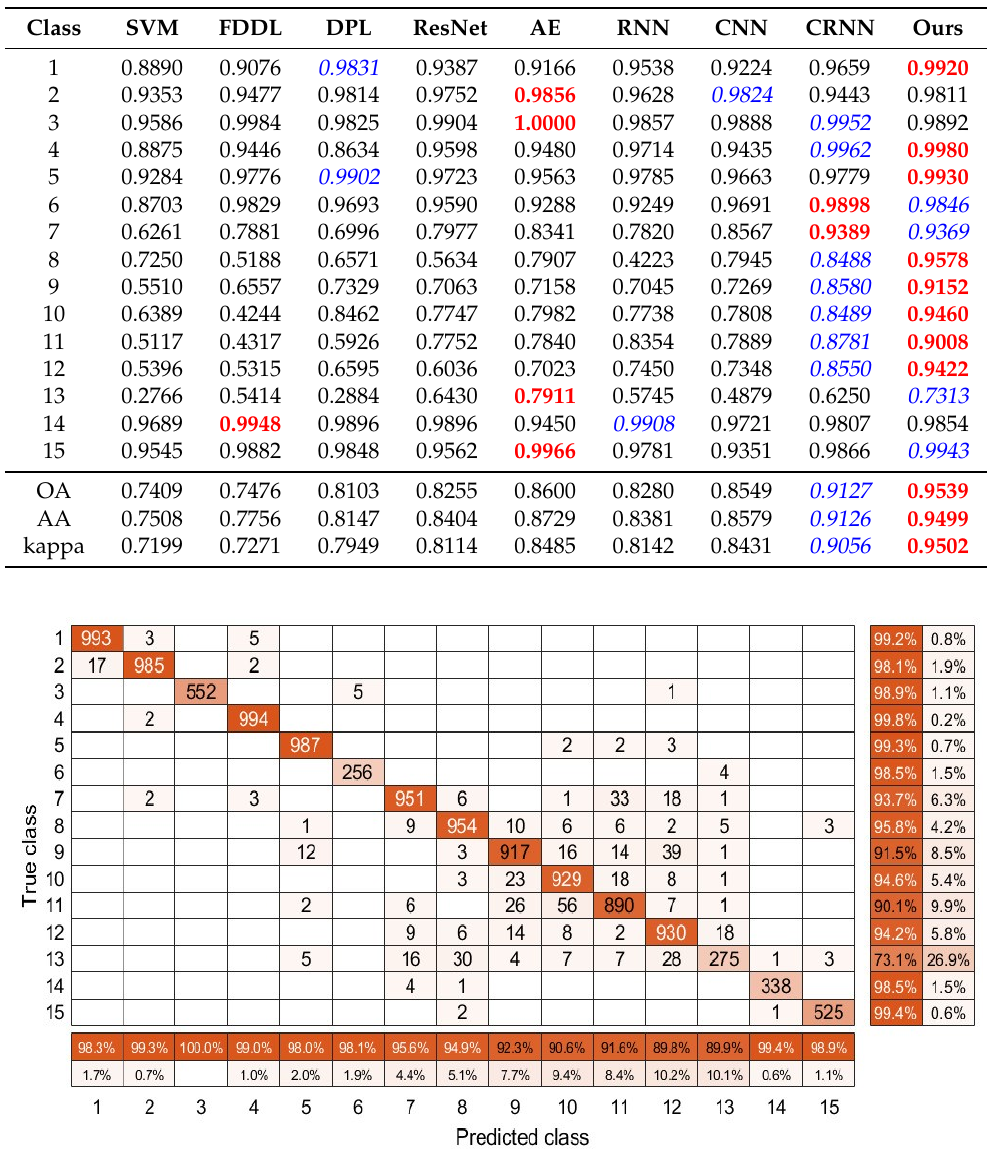
Figure 11. Confusion matrix of the developed model on the Houston 2013